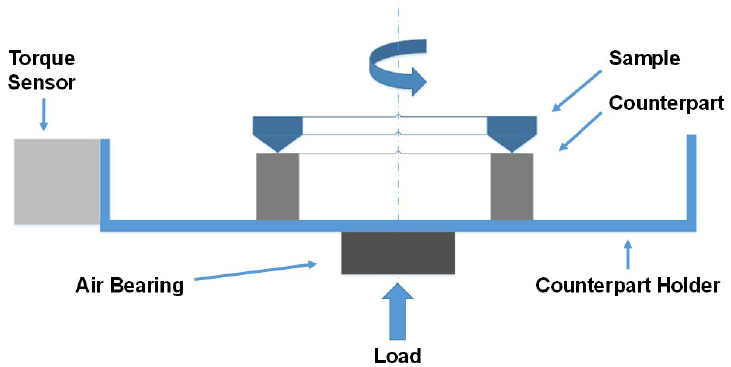
Figure 1. Principle of ring on disc test on TE-93.